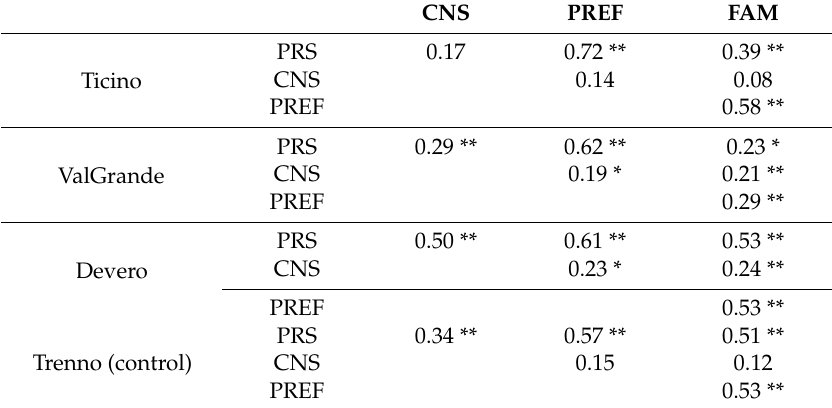
Table 5. Pearson’s correlations between the connectedness to Nature scale (CNS), the perceived restorativeness scale (PRS), preference (PREF), and familiarity (FAM) scores for each